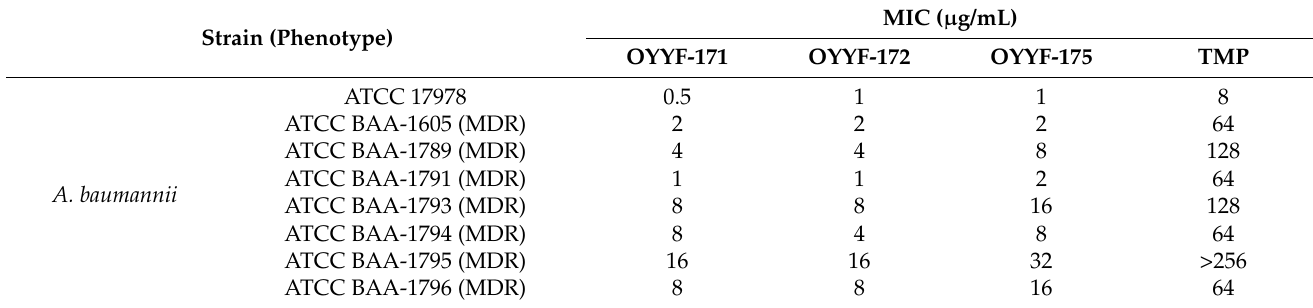
Table 2. MICs of OYYF-171, -172, -175, and TMP against ATCC strains of A. baumannii .